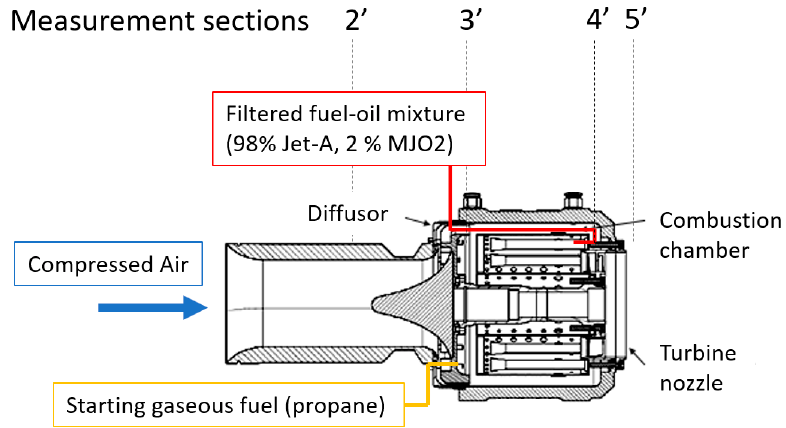
Figure 1. GTM-120 stationary combustion chamber test stand (test stand no. 1).